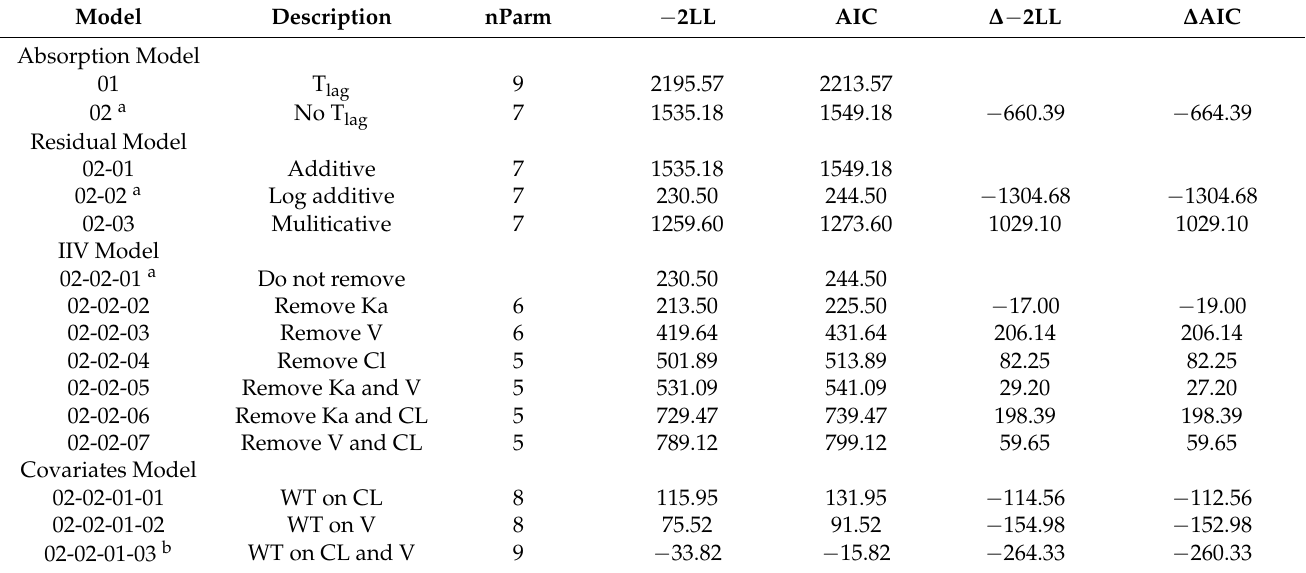
Table 3. Summary of the model building steps for the population PK of